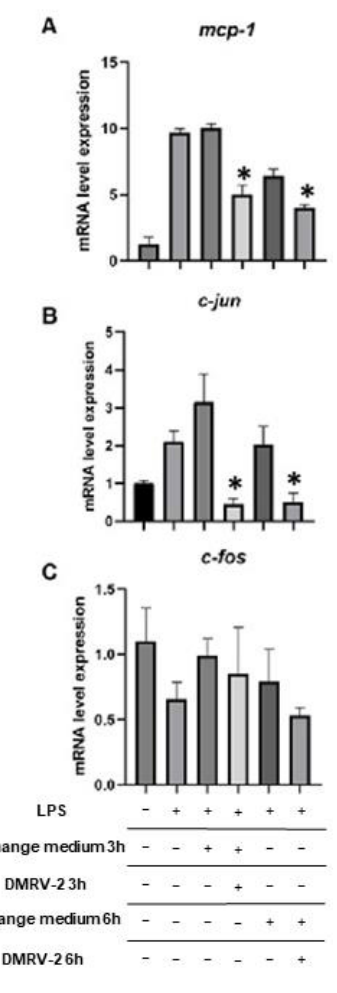
Figure 6. RT-qPCR-measured levels of MCP-1 ( A ), c-Jun ( B ) and c-Fos ( C ) mRNAs in HUVECs following different treatments. HUVECs were stimulated with 0.1 µ g/mL LPS for 4 h and then incubated with DMVR-2 or underwent change of the medium. RT-qPCR analyses were performed after LPS stimulation, and after 3 h or 6 h of different incubations. * p < 0.05 vs. respective controls. Given the particular nature of AP-1, which can exist as a Jun/Fos heterodimer or a Jun/Jun homodimer, these data suggest that the inflammation induced by LPS could favor the homodimer formation. Accordingly, when treating the inflamed cells with a magno- lol-containing preparation, the c-Jun mRNA returned to a basal level, thus restoring the correct balance with c-Fos and favoring the normal formation of the heterodimer. 3. Materials and Methods 3.1. Reagents and Materials Ultra-pure acetonitrile, water, methanol, and formic acid for LC-MS analysis were purchased from Romil Ltd. Pure Chemistry (Cambridge, UK). The solvents for the extrac- tion were purchased from Sigma Chemicals Company (Milan, Italy). For the quantitative analyses, the following standards were used: ruscogenin and procyanidin B1 obtained from DBA Italia s.r.l. (Milan, Italy), magnolol obtained from Activate Scientific GmbH